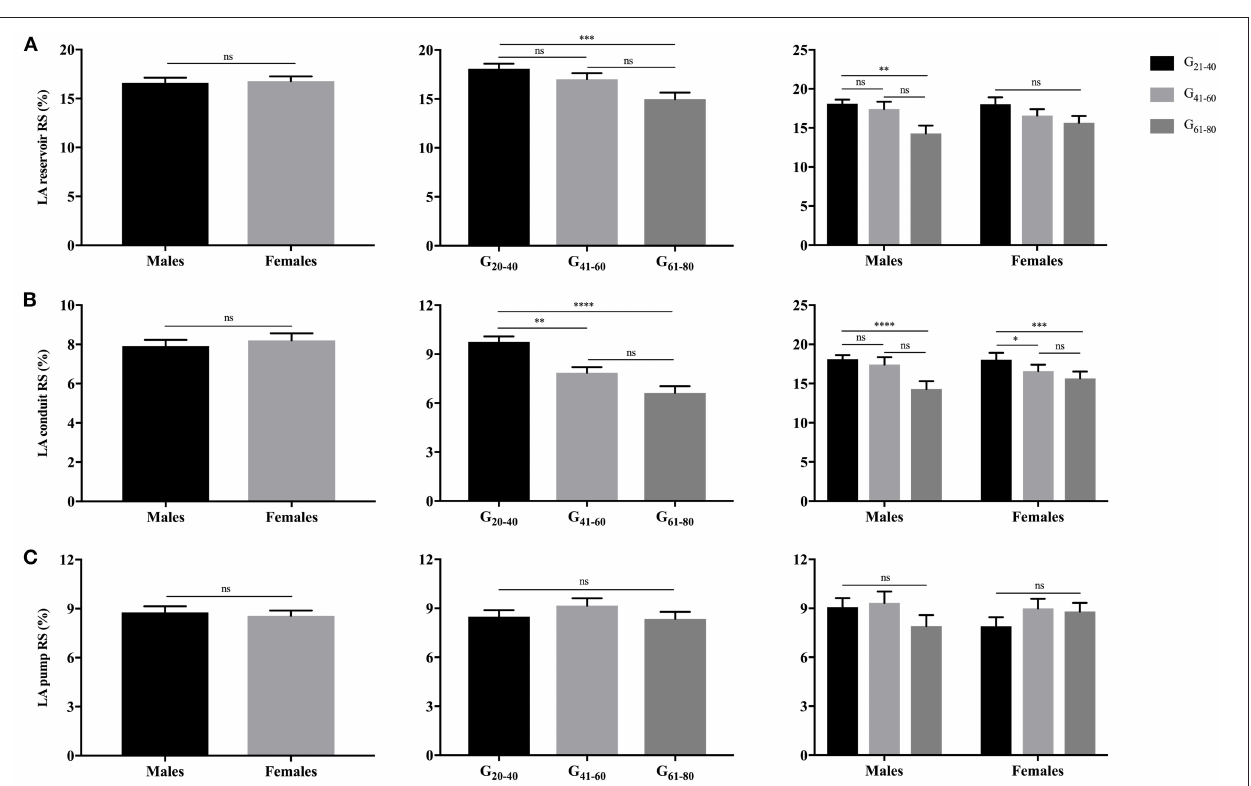
FIGURE 3 | Gender- and age-related differences of LA reservoir RS (A) , conduit RS (B) , and pump RS (C) . * P < 0.05, ** P < 0.01, *** P < 0.001, **** P < 0.0001: age-related difference; ns, not significant.